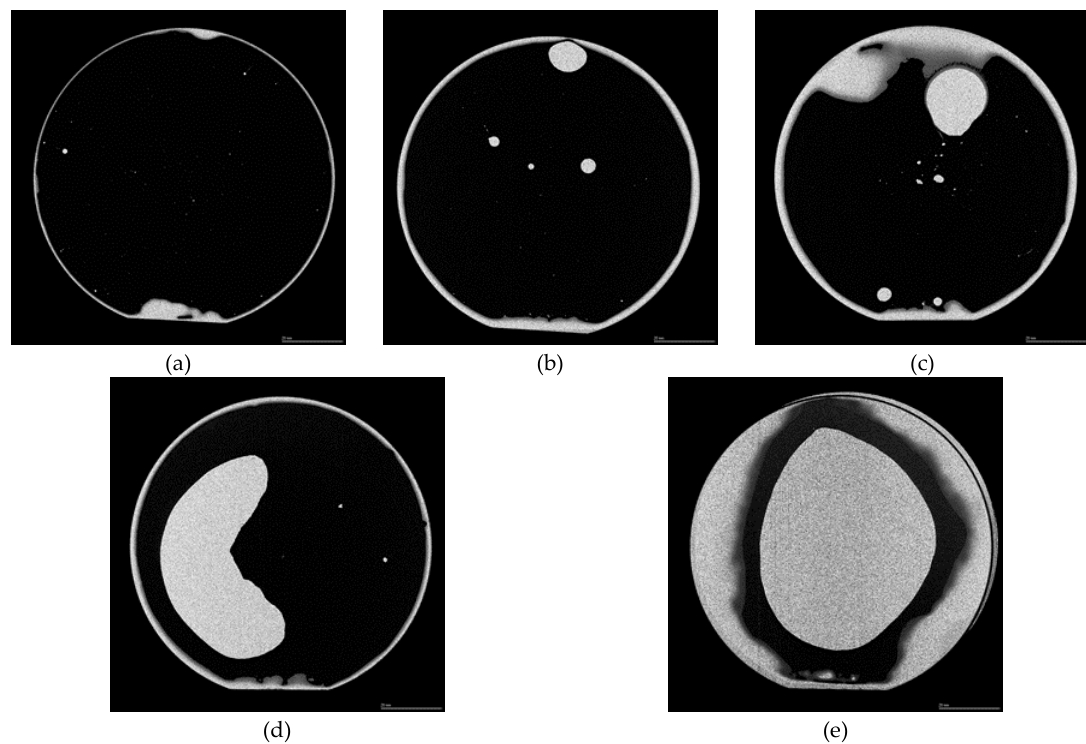
Figure 7. Typical surface acoustic microscope (SAM) images of room-temperature pressureless wafer-scale bonding with Au film thicknesses of ( a )–( e ) 15, 50, 100, 300, and 500 nm, respectively.